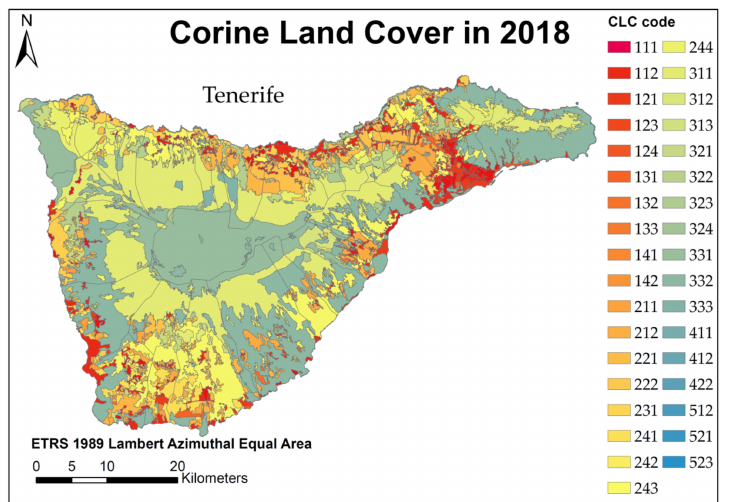
Figure 16. Thematic cartography regarding the land-use changes in the Canary Archipelago in the year